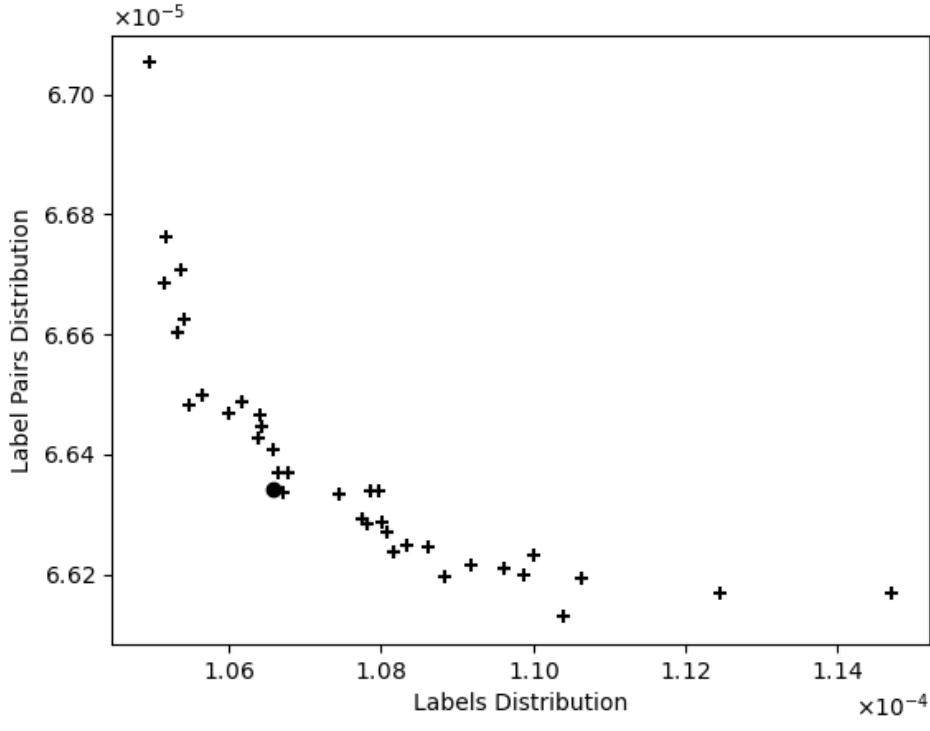
Figure 2. Final set of solutions for a run of the MOEA algorithm to split the Corel5k data set. Selected global optimum is marked with a